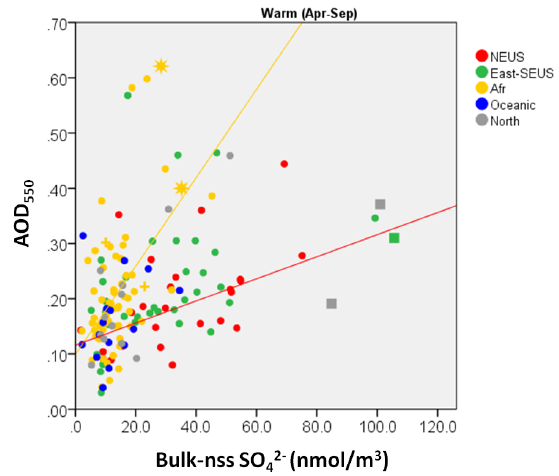
Fig. 10. MODIS regional aerosol optical depth (AOD, 550nm) ver- sus bulk nss SO 2 − concentration by flow patterns during the warm 4 season months of April to September; symbols are as defined in Fig. 7. Regression lines for NEUS, r = 0 . 51 with an intercept of 0.12 and a slope of 0.002, and for AFR, r = 0 . 53 with an intercept of 0.10 and slope of